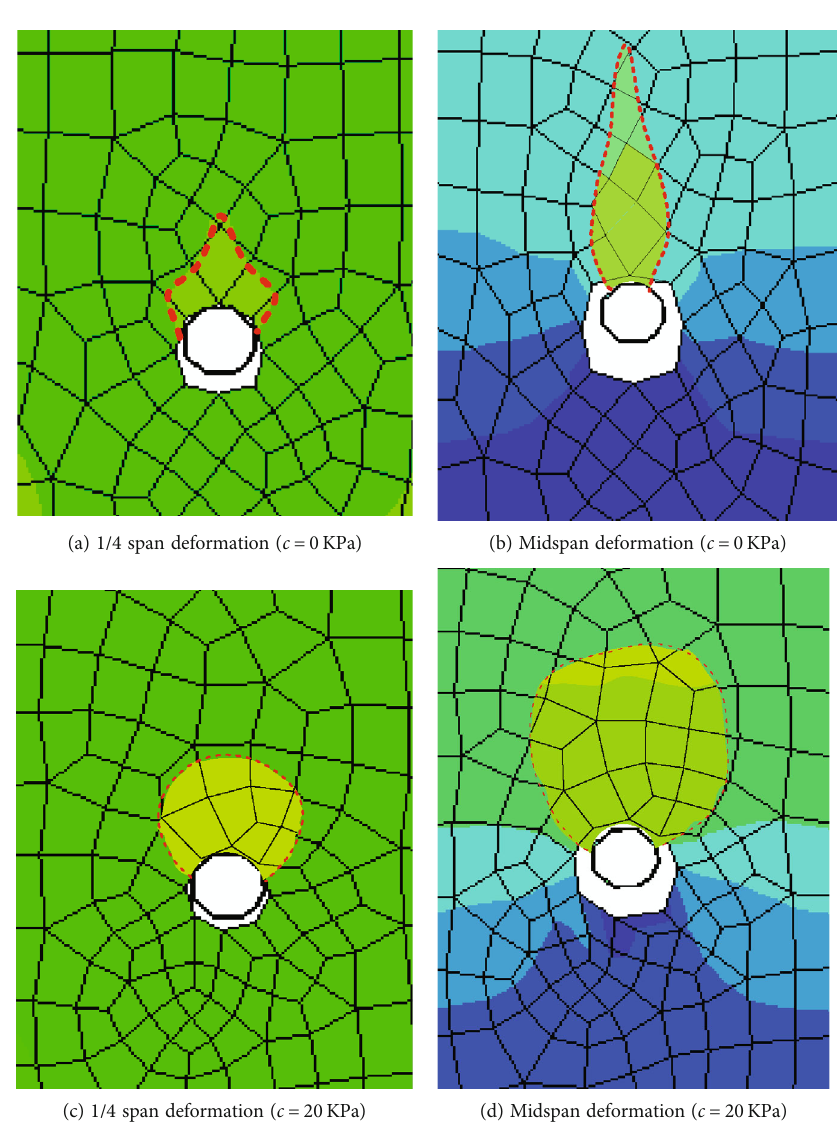
Figure 9: Deformation of soil in pipeline